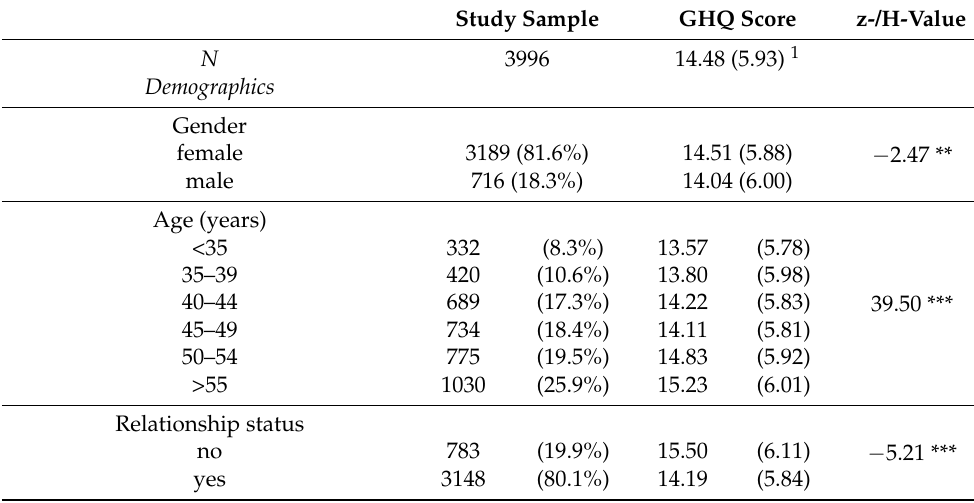
Table 1. The demographic variables and GHQ scores of the study